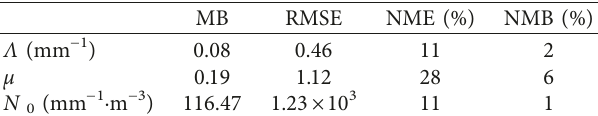
Figure 5: Retrieval results of the DSD parameters (first group); scatters are the true values vs. the retrieval values, and the solid lines represent the fitted regression lines from scatters. Table 4: Statistical parameters of the first group for the